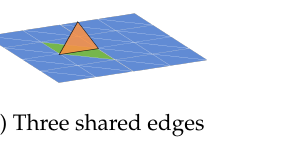
Figure 7. Examples of non-manifold meshes where an edge is shared by more than two triangles. This common edge is shared by green and orange triangles. The green triangles form a two-manifold mesh with the blue triangles while the orange triangle(s) do not. The orange triangles in ( a , b ) have sufficiently different normals such the green triangles half-edges can be easily linked. However all triangles in ( c ) have nearly equal normals making this